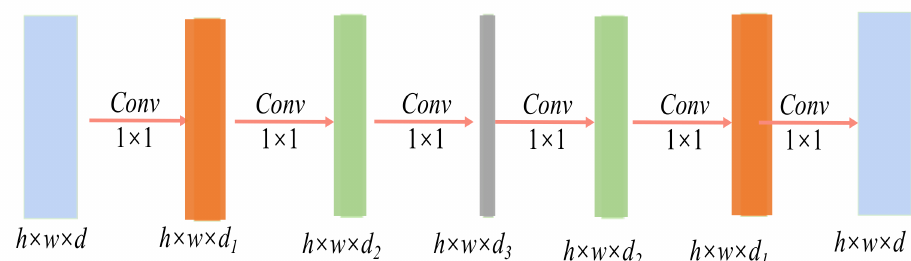
Figure 2. The architecture of the